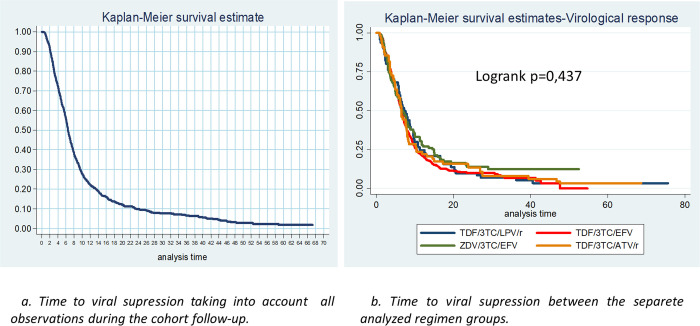
Survival curves for virologic response considering total observations during follow-up and different regimens.